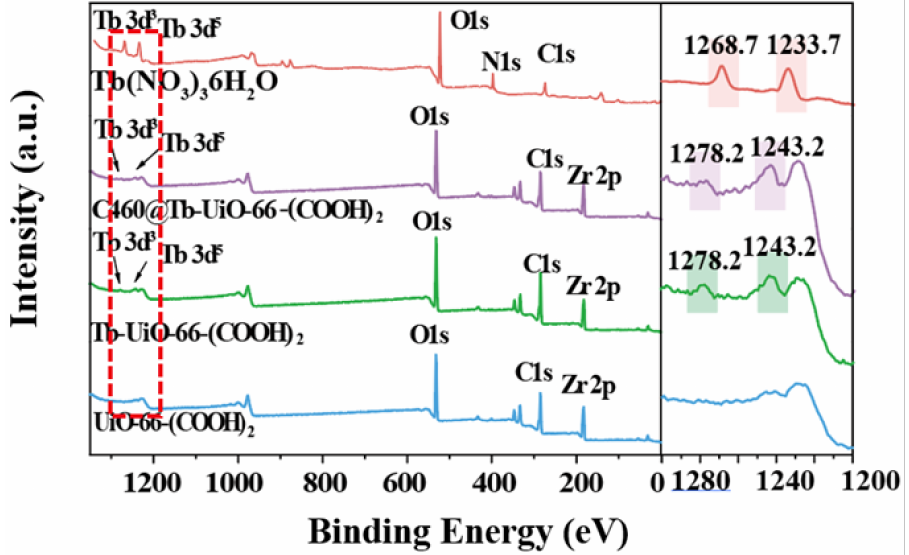
Figure 2. XPS spectra analysis of Tb(NO 3 ) 3 · 6H 2 O, UiO-66-(COOH) 2 , Tb-UiO-66-(COOH) 2 , C460@Tb- UiO-66-(COOH) 2